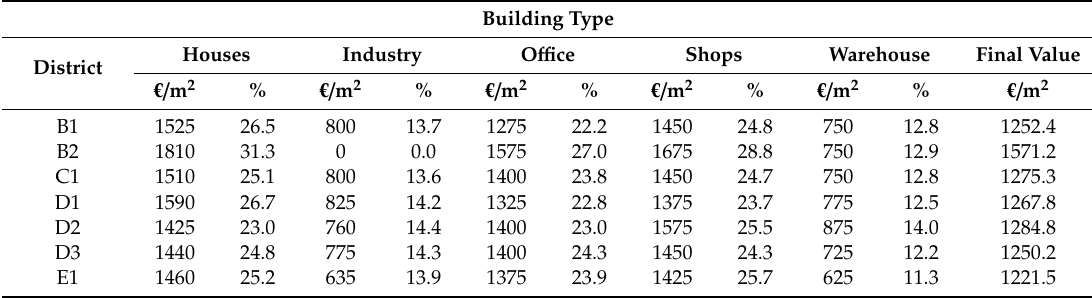
Table 2. Value and frequency of the di ff erent economical uses by